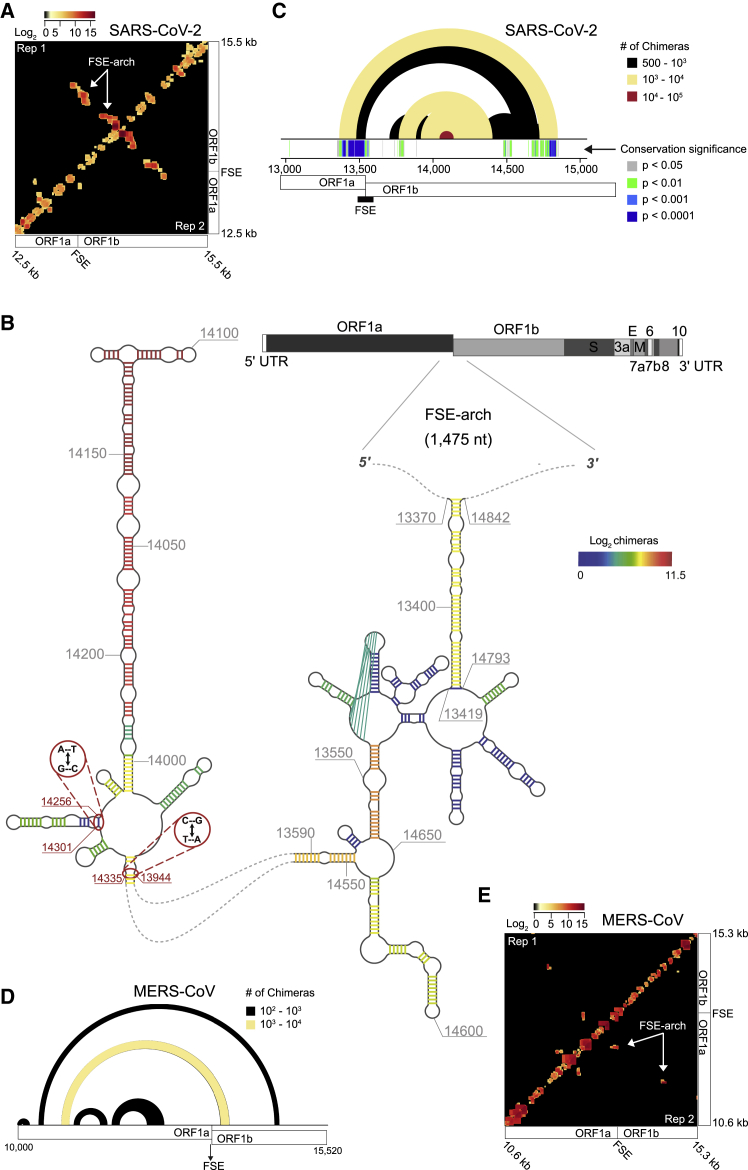
The Structure of the Ribosomal Frameshifting Element Arch (FSE-Arch) Inside Cells(A) Heatmap of RNA-RNA interactions around the SARS-CoV-2 FSE. Signal represents base-pairing between the genomic coordinates on the x and y axes. Top left and bottom right represent two independent biological replicates. Color code corresponds to the number of non-redundant chimeric reads supporting each interaction. Arrows indicate the FSE-arch signal.(B) Arch plot representation of long-range RNA-RNA interactions around SARS-CoV-2 FSE. Conservation significance is shown below the arches. Black rectangle indicates the FSE position. Top color code corresponds to the number of non-redundant chimeric reads supporting each arch. Bottom color code corresponds to the conservation significance (Synplot p values).(C) The structure around the SARS-CoV-2 FSE. Colors represent the number of chimeric reads supporting each base pair. Red circles (positions 13,944 and 14,256) indicate covariation positions.(D) Arch plot representation of long-range RNA-RNA interactions around the MERS-CoV FSE. Color code corresponds to the number of non-redundant chimeric reads supporting each arch.(E) Heatmap of RNA-RNA interactions around the MERS-CoV FSE. Signal represents base-pairing between the genomic coordinates on the x and y axes. Top left and bottom right represent two independent biological replicates. Color code corresponds to the number of non-redundant chimeric reads supporting each interaction. Arrows indicate the MERS-CoV FSE-arch signal.See Figure S5 for statistical significance and the full sequence of the FSE-arch.